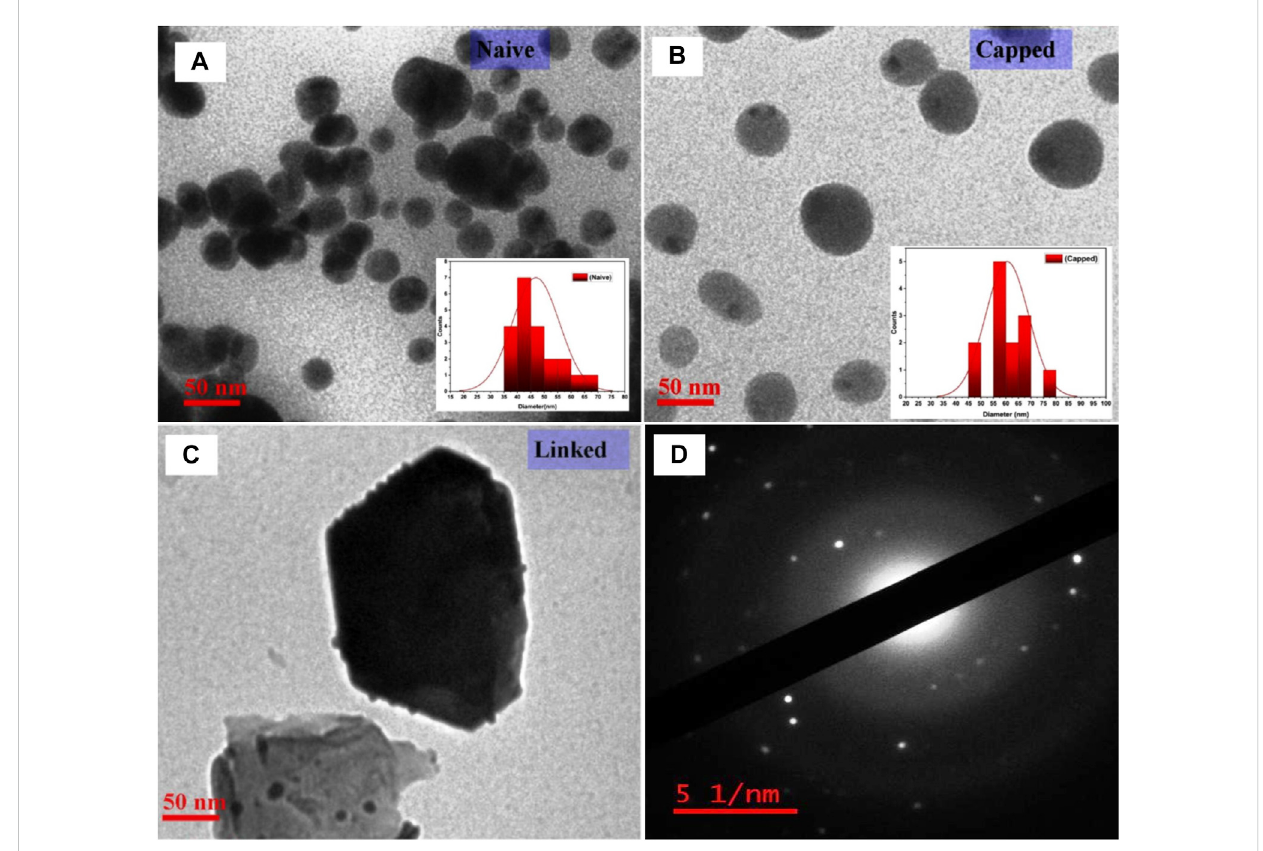
FIGURE 7 Characterization of AuNPs using TEM-SAED with, (A – C) TEM micrograph analysis indicating the sizes of the nanoparticles as ~50 nm, ~64 nm, and 110 nm for naive, capped, and linked AuNPs, respectively, with the relative shift in particle size on analysis by UV-vis spectroscopy, and (D) TEM-SAED showing patterns with bright spots of concentric circular rings (center to periphery) corresponding to the (111), (200), and (220) lattice planes of polycrystalline